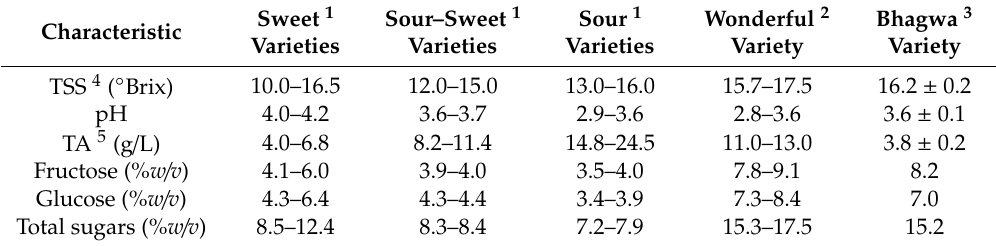
Figure 1. Major polyphenols, organic acids, alkaloids, and lignans of the pomegranate fruit. Table 2. Physicochemical characteristics of pomegranate varieties’ juices.